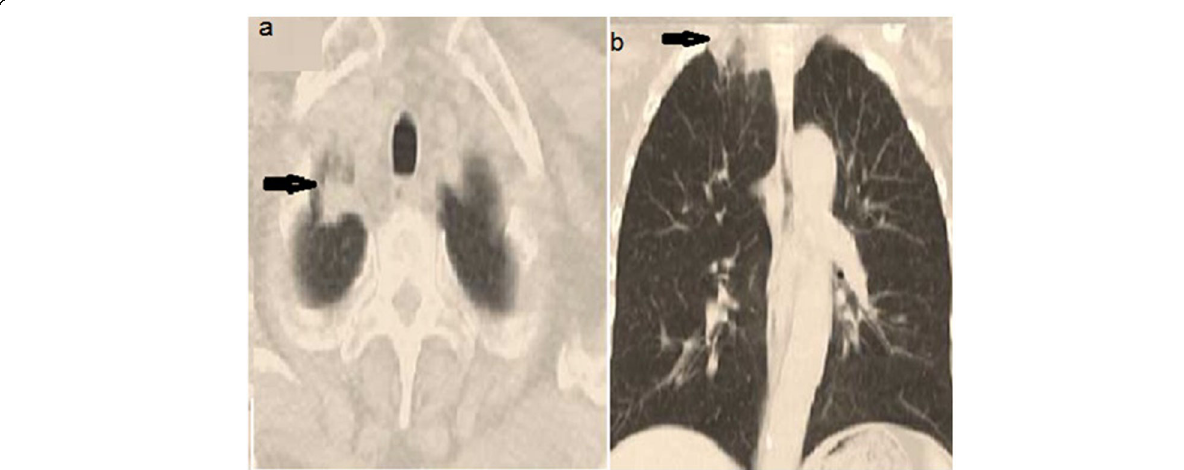
Fig. 5 “ A 52-year-old female patient with a history of treated breast cancer since 1.5 years. ” Follow-up MCCT exam revealed an irregular well- defined semi-solid nodule at the anterior segment of the Rt. upper lung lobe ( a ) axial ( b ) coronal image that is categorized as lung-RADS score 4A “ malignant nodular lesion. ” Pathology results newly developed small cell